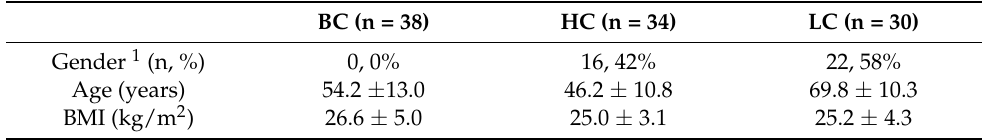
Table 1. Summary data of the participants in the